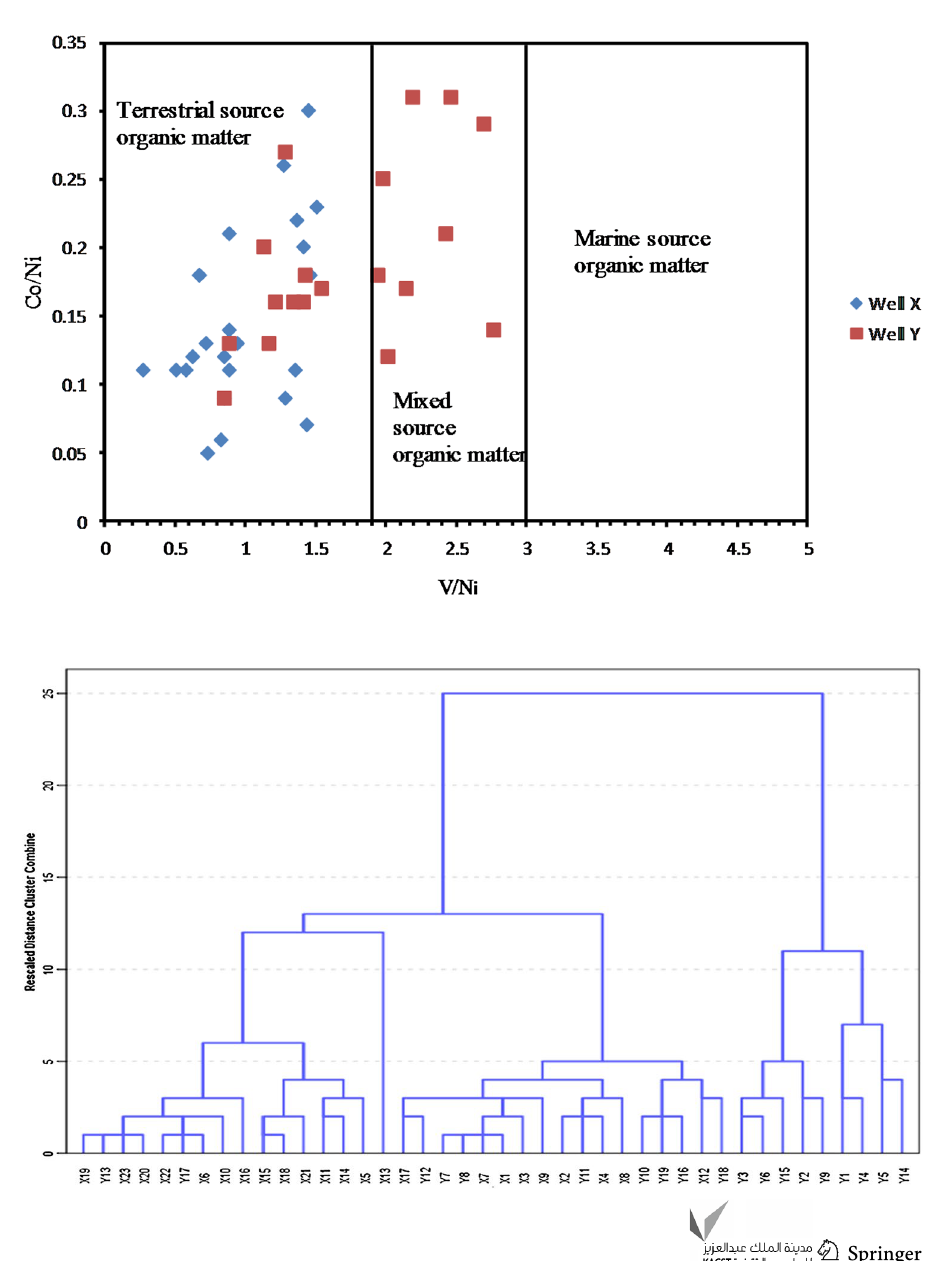
Fig. 6 Cross-plot of Co/Ni versus V/Ni indicating that kerogens from the central Niger Delta have both terrestrial and mixed marine/terrestrial origins.